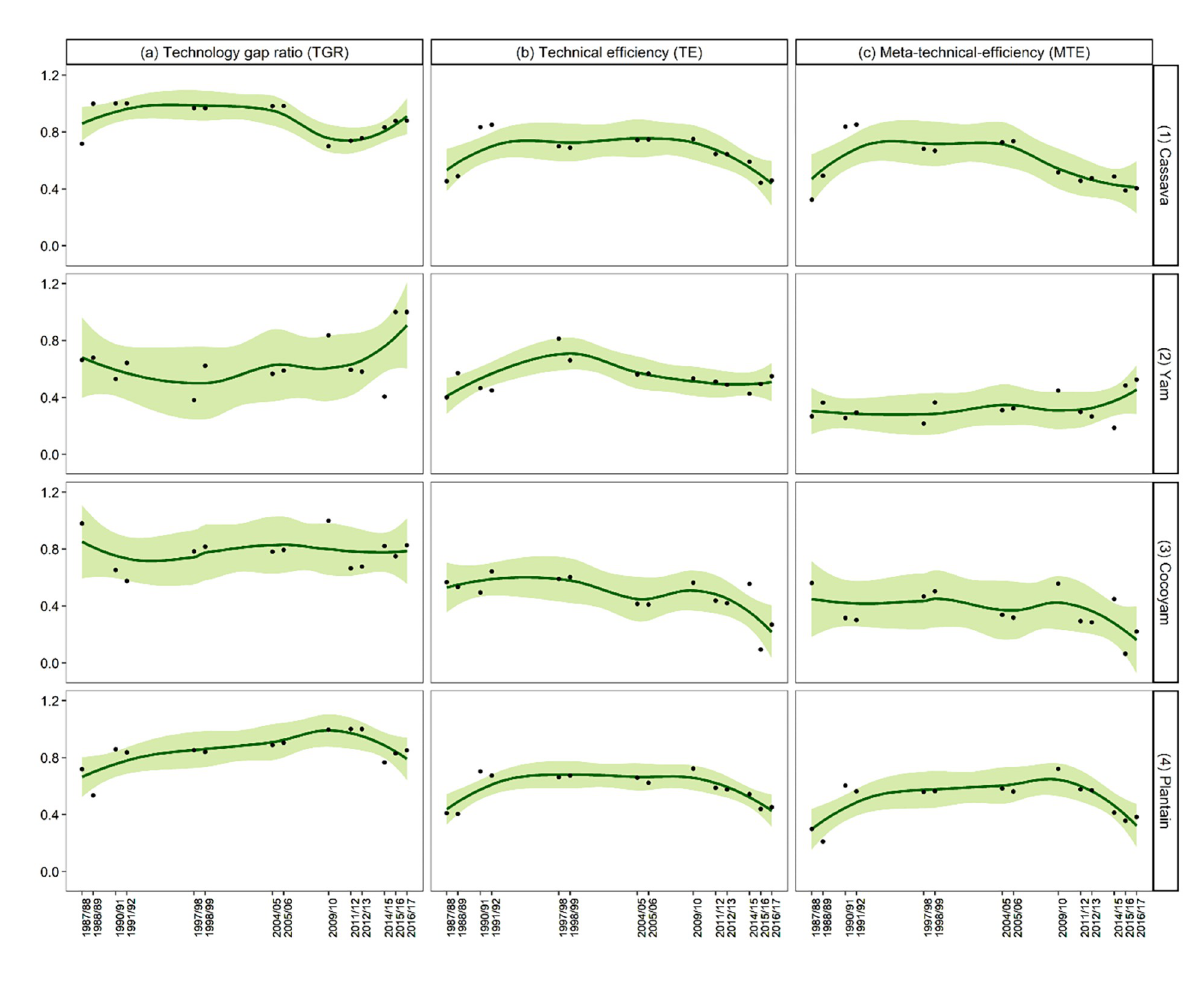
Fig 1. Ghanaian starchy staple production technology level and technical efficiency parameters across seasons (1987–2017). Notes: Farmer- level scores were first estimated via a Meta − stochastic − frontier (MSF) analysis applied separately to 9 population − based surveys that represent 30 years of farmer-level data collection in Ghana the surveys used included Ghana Living Standards Surveys [wave 1 − 7] and Ghana Socioeconomic Panel Survey [wave 1 − 2]. The farmer-level elasticities were subsequently averaged across seasons via a regression framework to account for controls. Each point on a sub − panel represents the mean of the estimates. Given the seasonal means, the fitted line was done locally using neighborhood points, weighted by distance. The size of the neighborhood was set to 75% of the points with a tri − cubic weighting. The gray region is the 95% confidence interval of the fitted